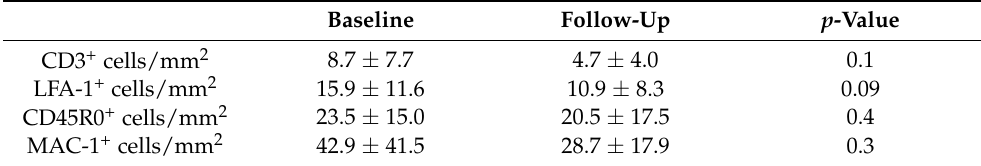
Table 3. Immunohistological biopsy findings at baseline and upon treatment at follow-up in responders.